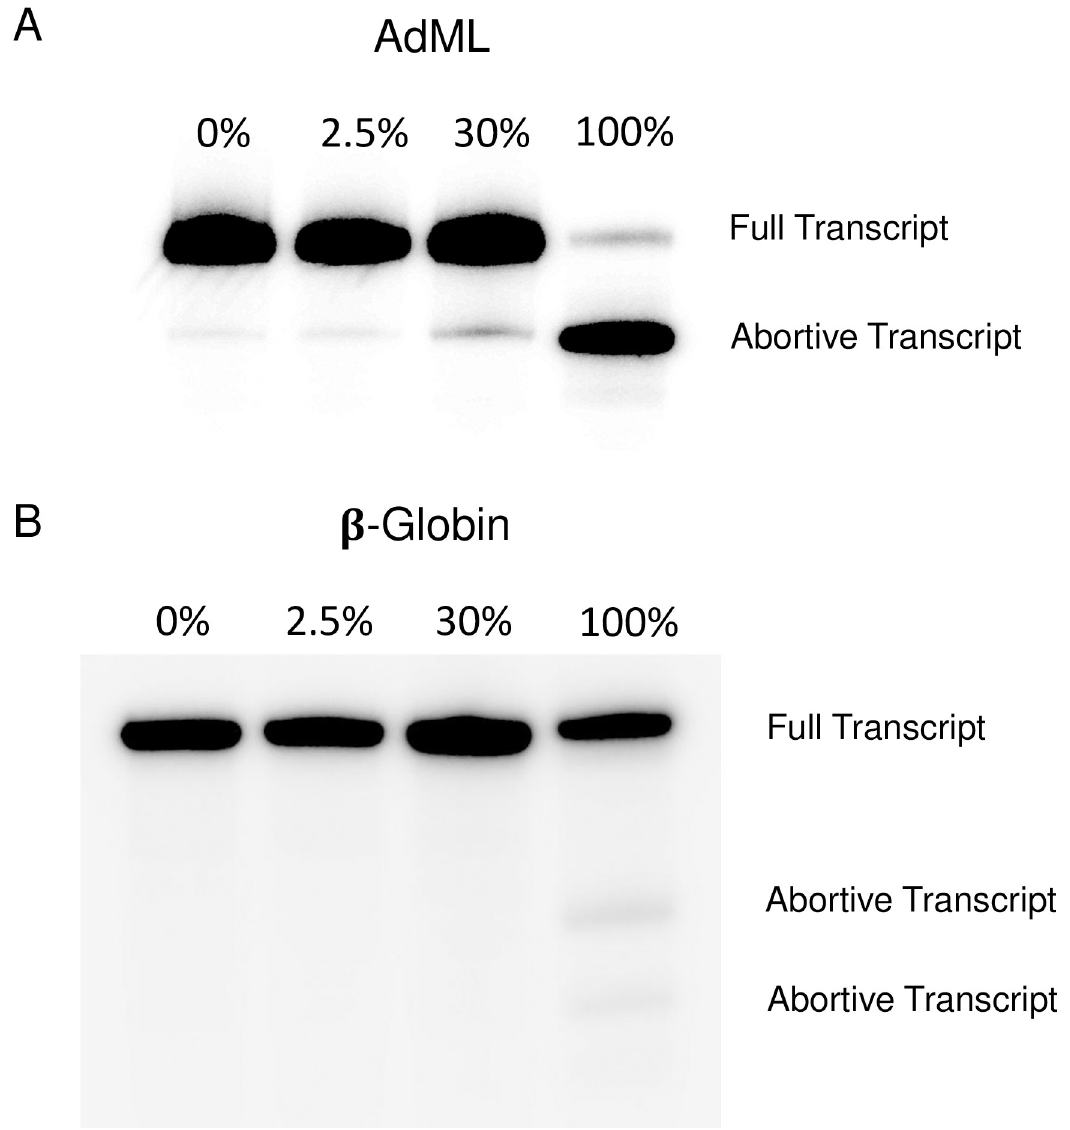
Fig 3. In vitro transcription of AdML and β -Globin. Autoradiograph depicting the T7 polymerase transcription profiles of (A) AdML and (B) β -Globin. Four transcripts of each minigene were created with varying amounts, 0%, 2.5%, 30%, and 100%, of 4sU incorporated. The full pre-mRNA strands and abortive transcripts in each lane are